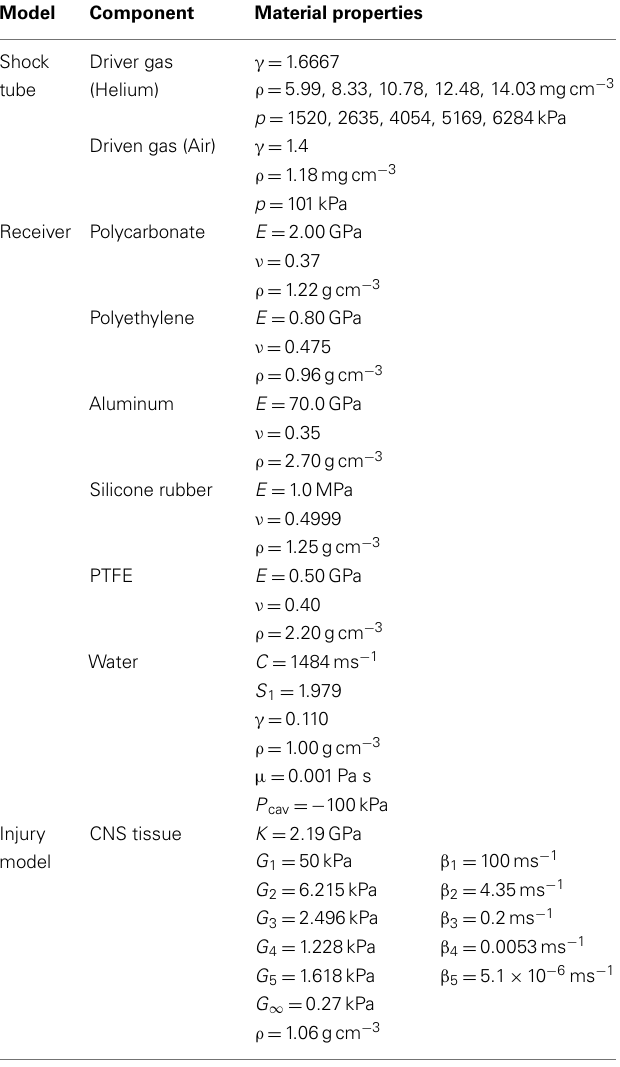
Table 1 | Summary of material properties used in the finite element